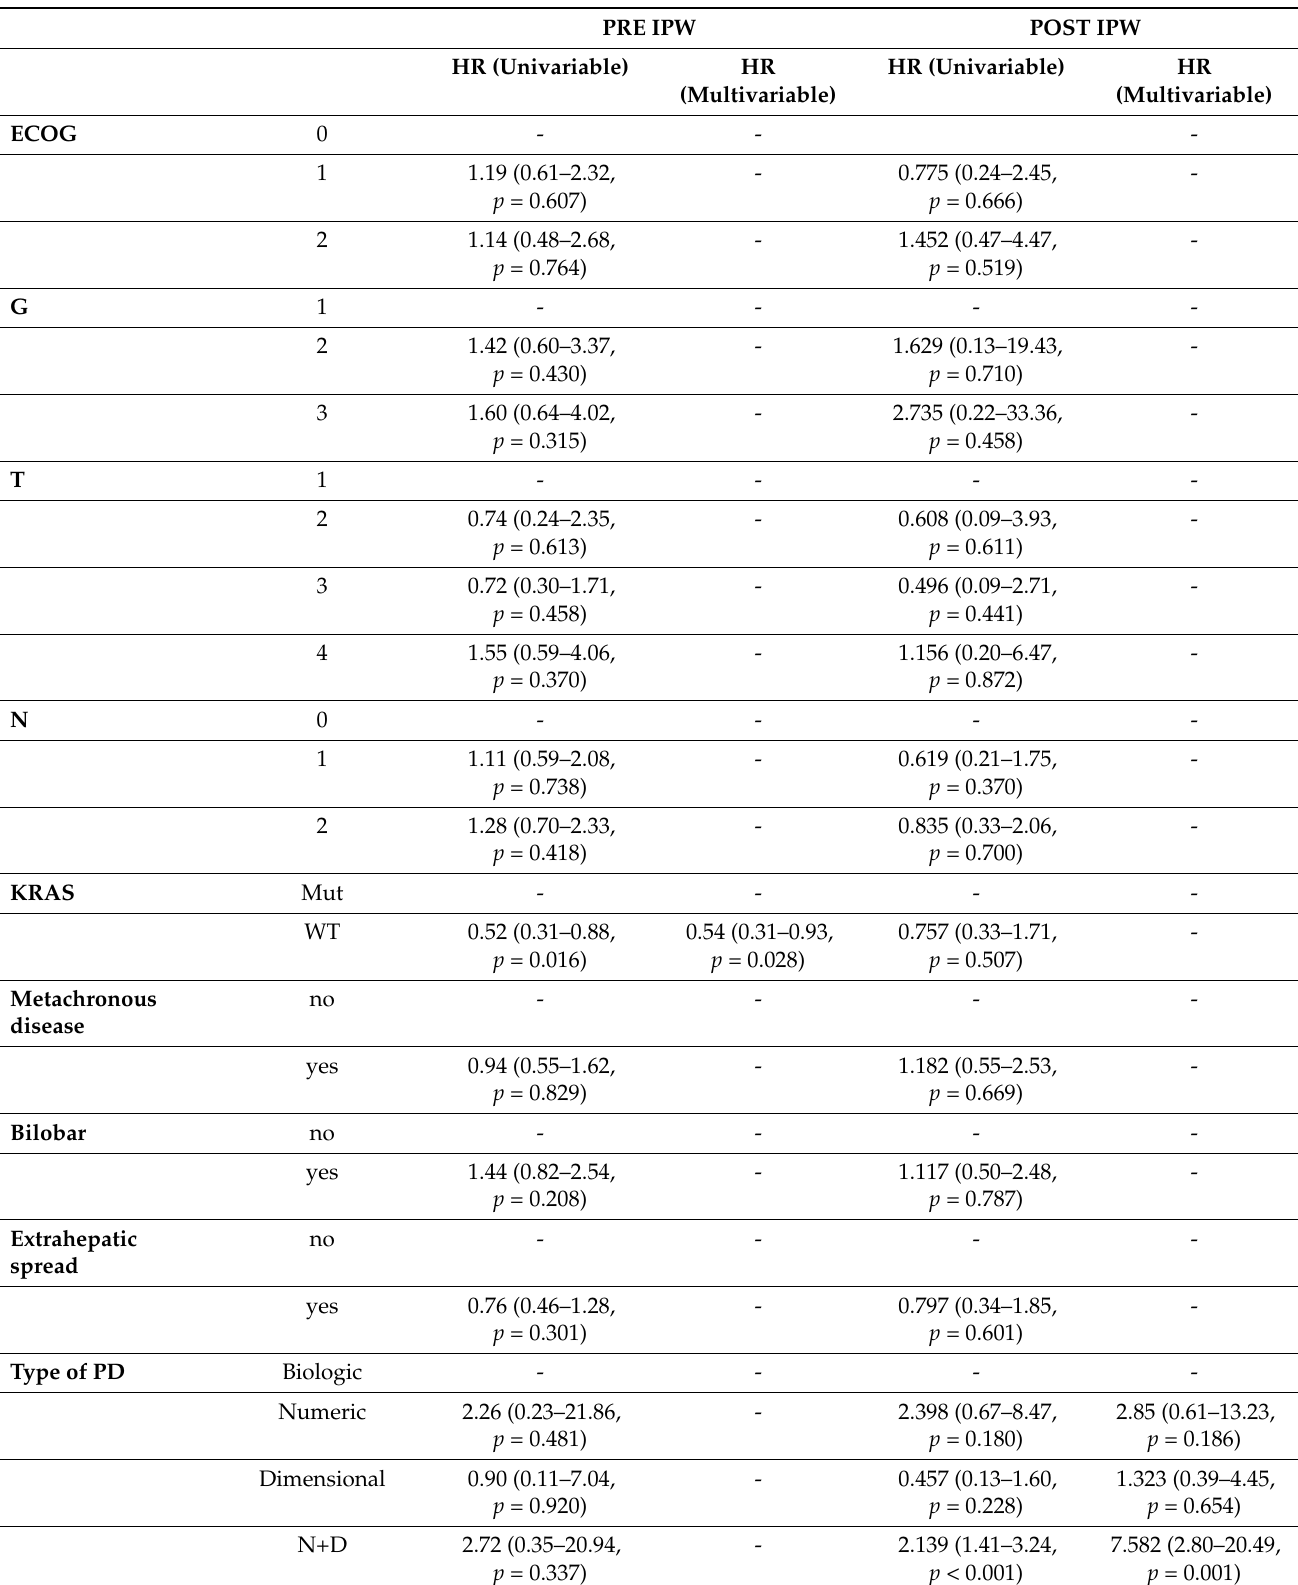
Table 2. Univariate and multivariate Cox regression analysis to assess the risk factors for overall mortality before and after